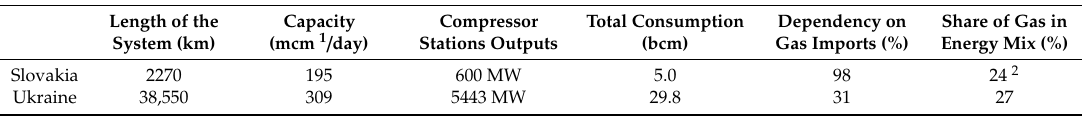
Table 1. Characteristics of Slovak and Ukrainian gas transmission system and their gas consumption (2019). Source: [50,51],